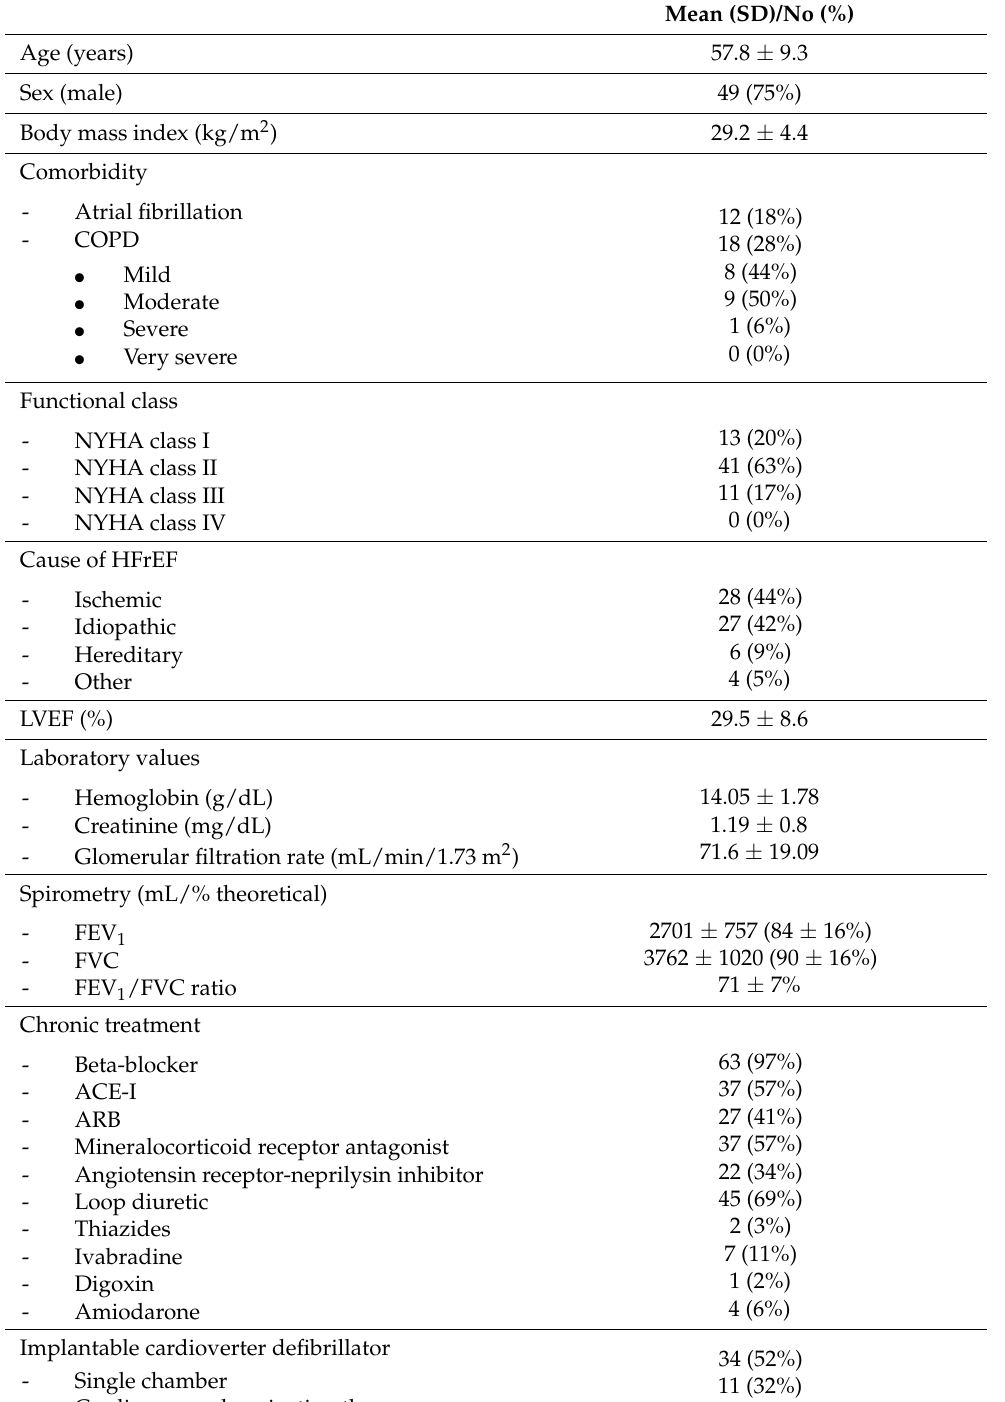
Table 1. Baseline characteristics of the included patients ( n = 65).